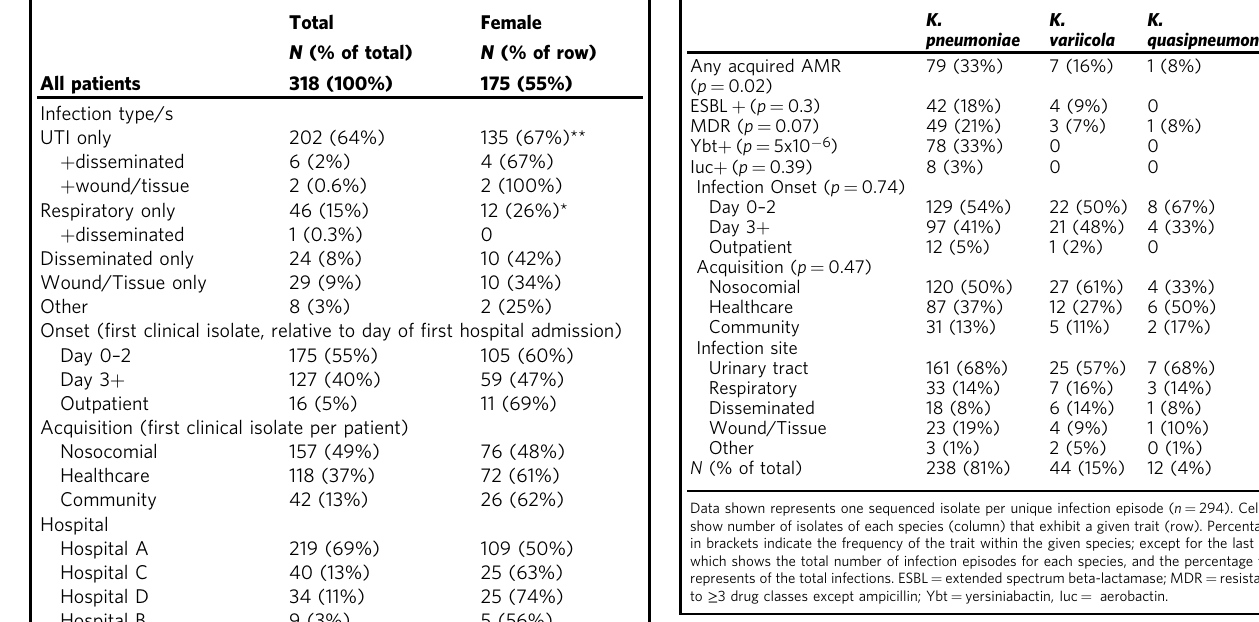
Table 2 Frequency of genetic features and infection characteristics, by species.